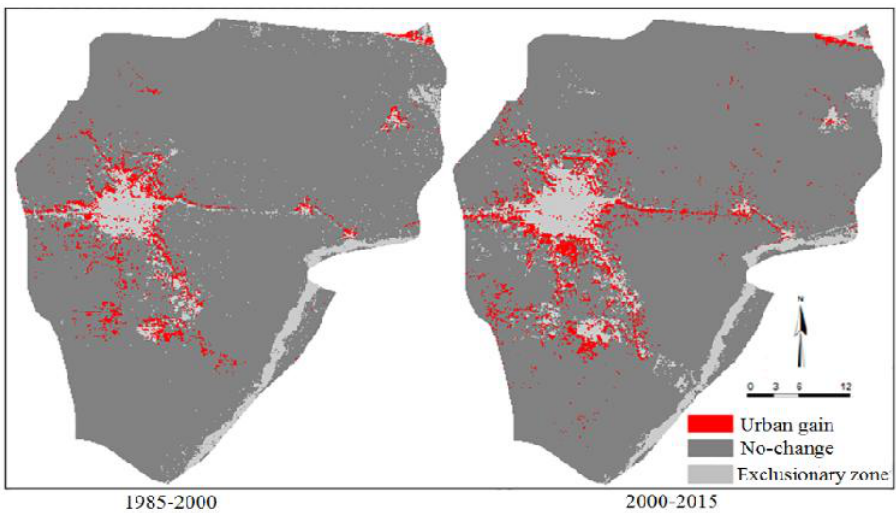
Figure 2 . Urban growth for the years between 1985 and 2000 and between 2000 and 2015.